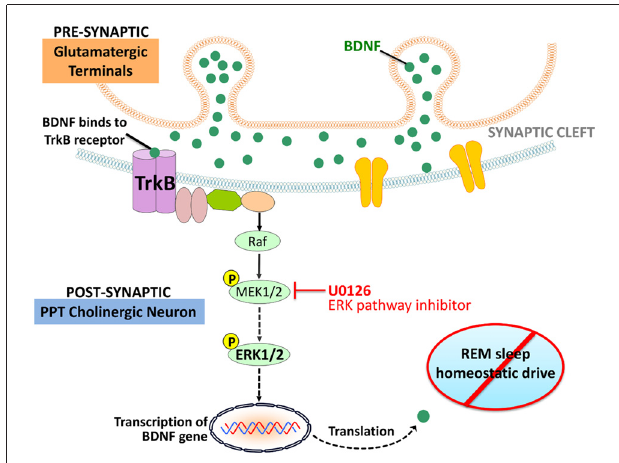
FIGURE 6 | Working model depicting molecular steps in the PPT cholinergic neurons involved in the regulation of RSHD. Arrows: normal activating effects on the target molecule. Dotted arrows: loss of activating effects on the target molecule due to application of U0126 (ERK1/2 activation